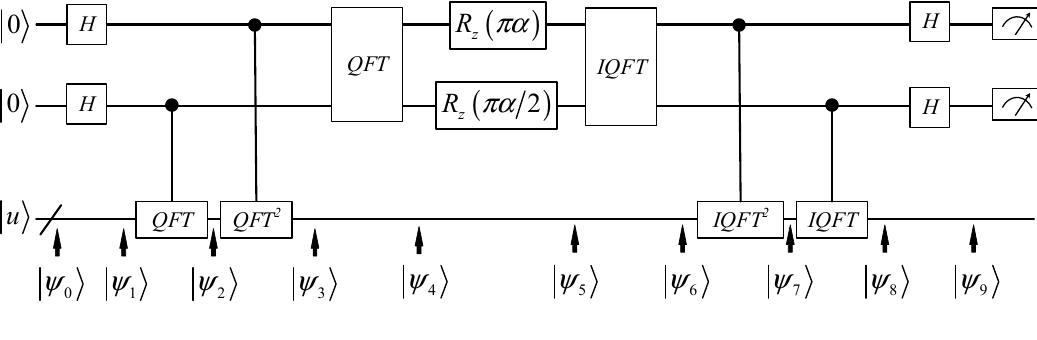
Figure 4. Circuit of the QWFRFT.